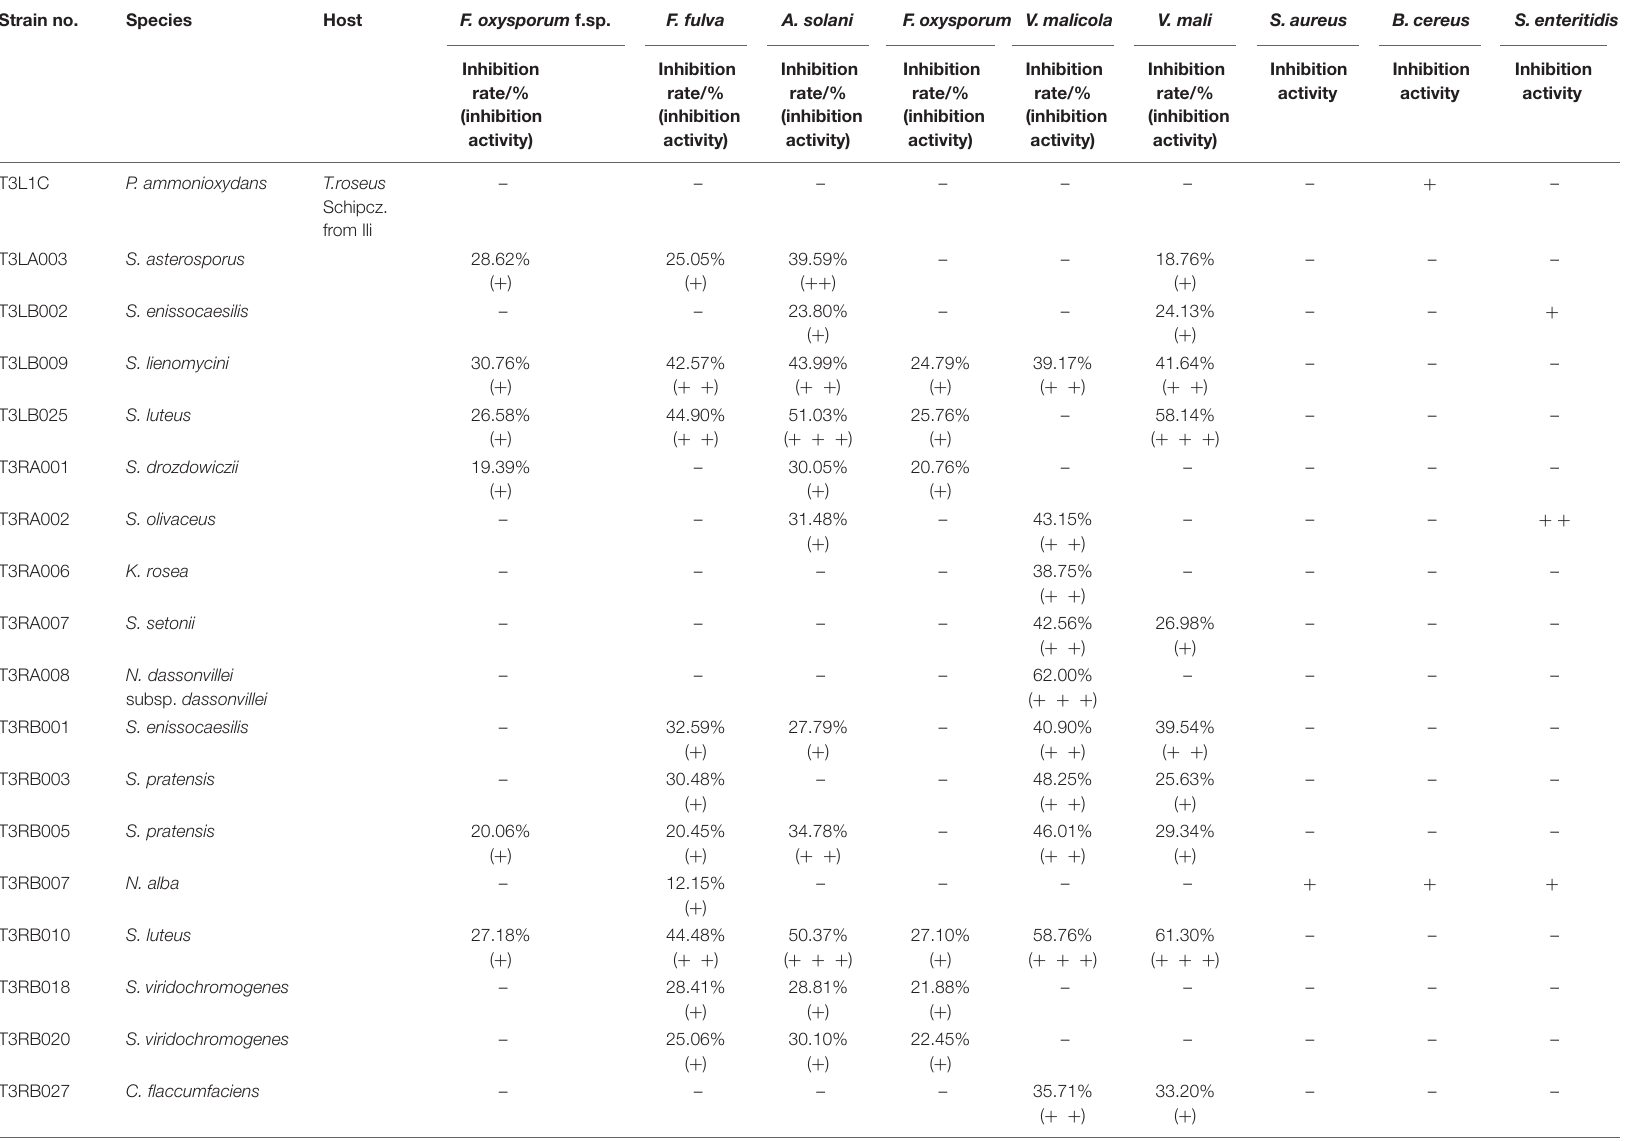
TABLE 3 | Antimicrobial activity of 54 endophytic actinomycetes on indicated fungal and bacterial strains. Strain